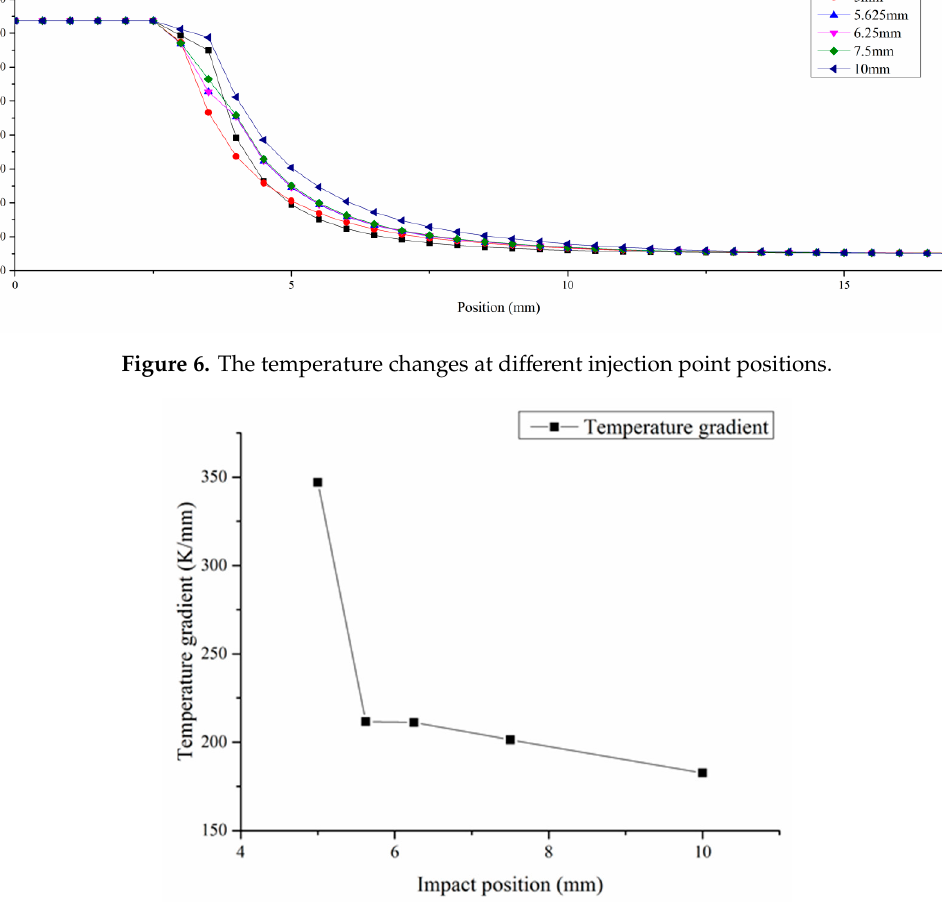
Figure 7. The temperature gradient changes at different injection point positions.